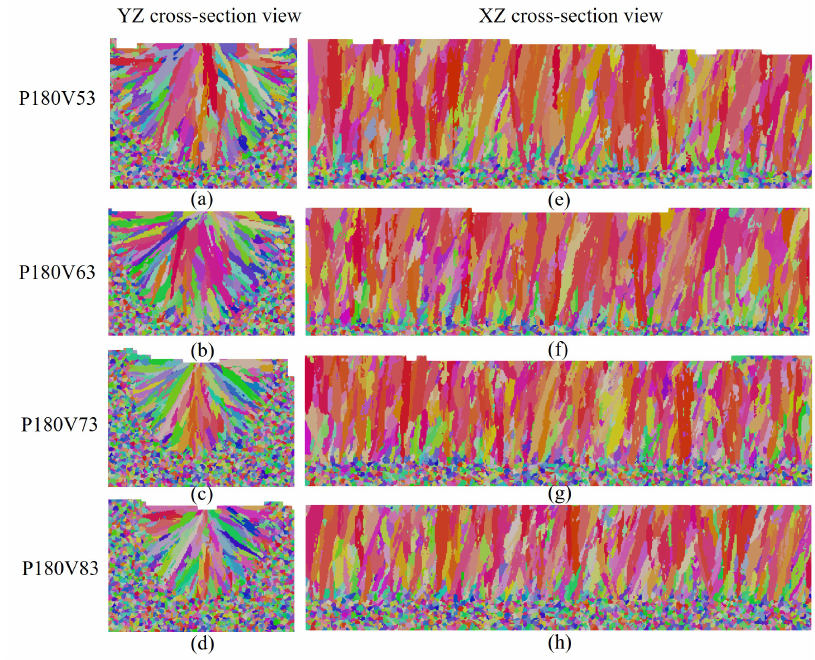
Figure 14. The grain structure cross sections: ( a – d ) transverse cross-section map, ( e – h ) lon- gitudinal cross-section map of the results for cases with laser power varied within the range [0.53 m/s, 0.83 m/s], and the constant laser power of 180